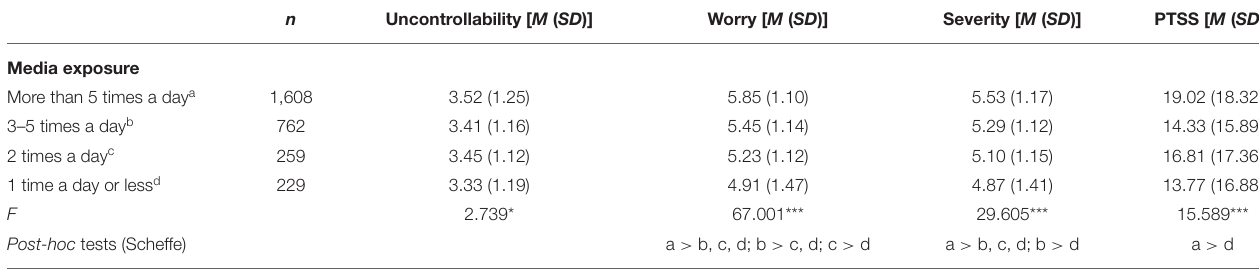
TABLE 3 | One-way ANOVA between media exposure, risk perception, and PTSS.